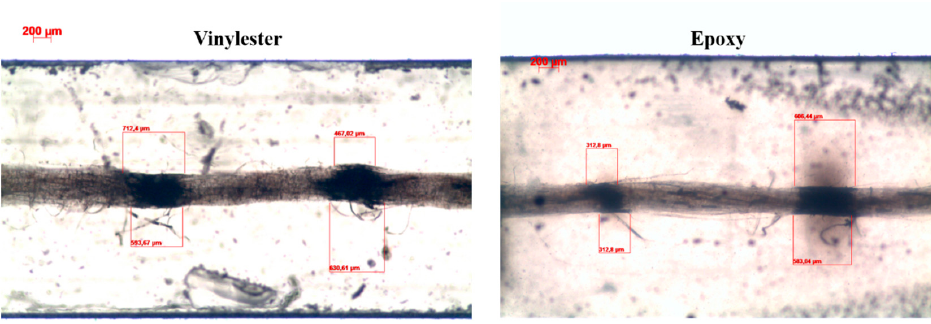
Figure 7. Typical optical micrographs of fragmented flax yarns in vinylester and epoxy matrices: measurement of the debonding length ( l debonding ). Table 4. Critical fragment length and debonding length values for the di ff erent single yarn